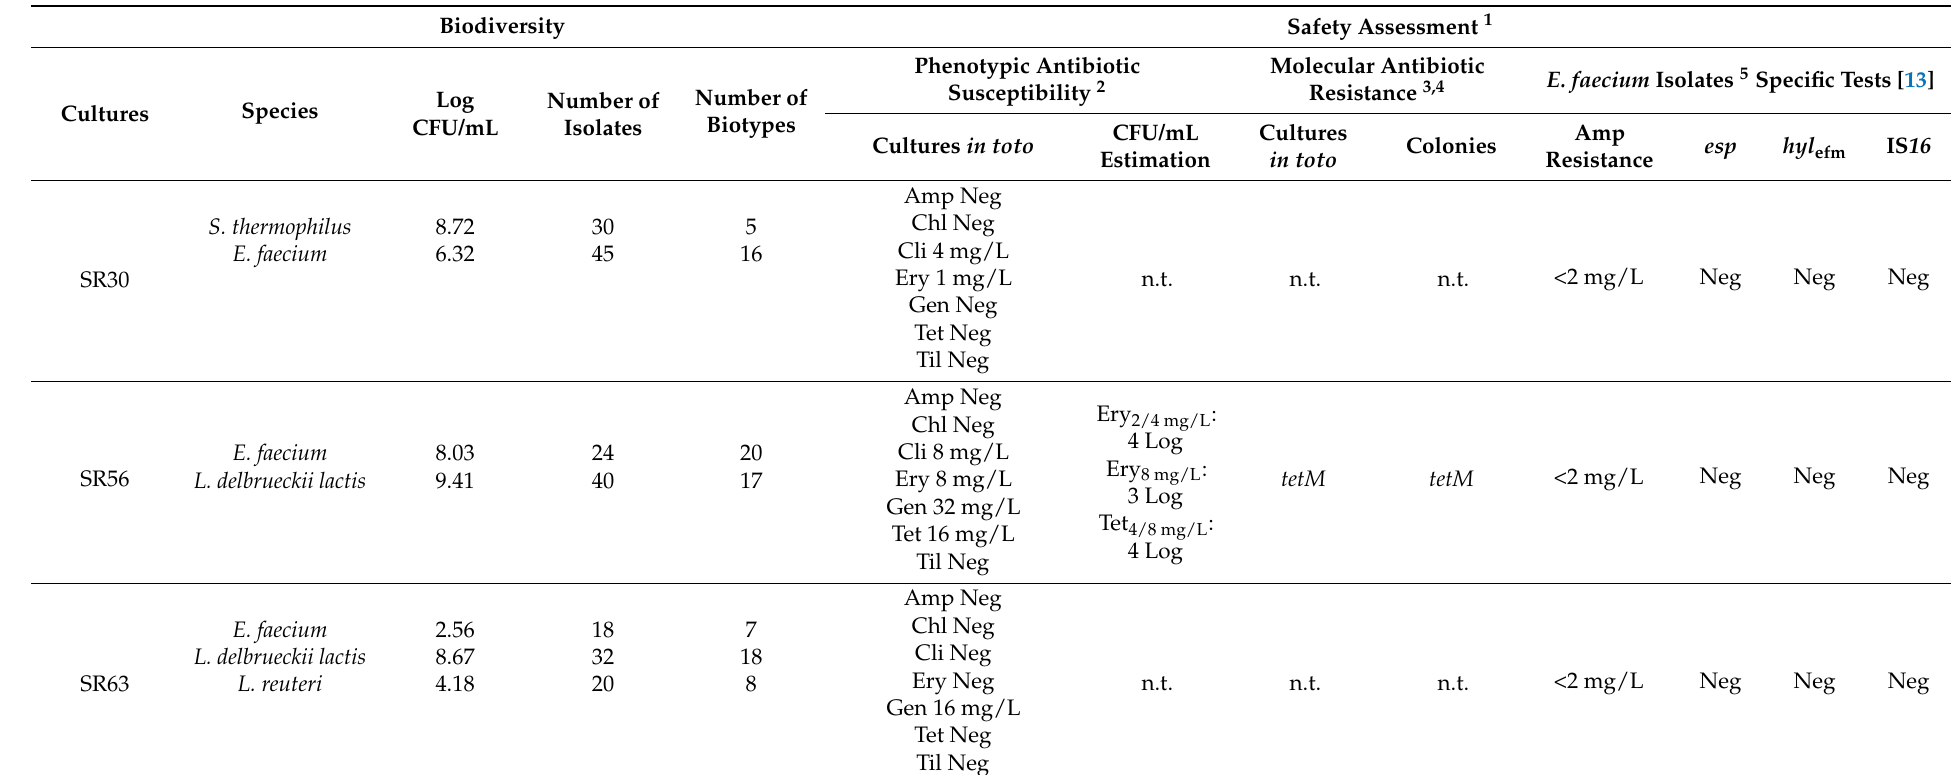
Table 3. Summary of the main